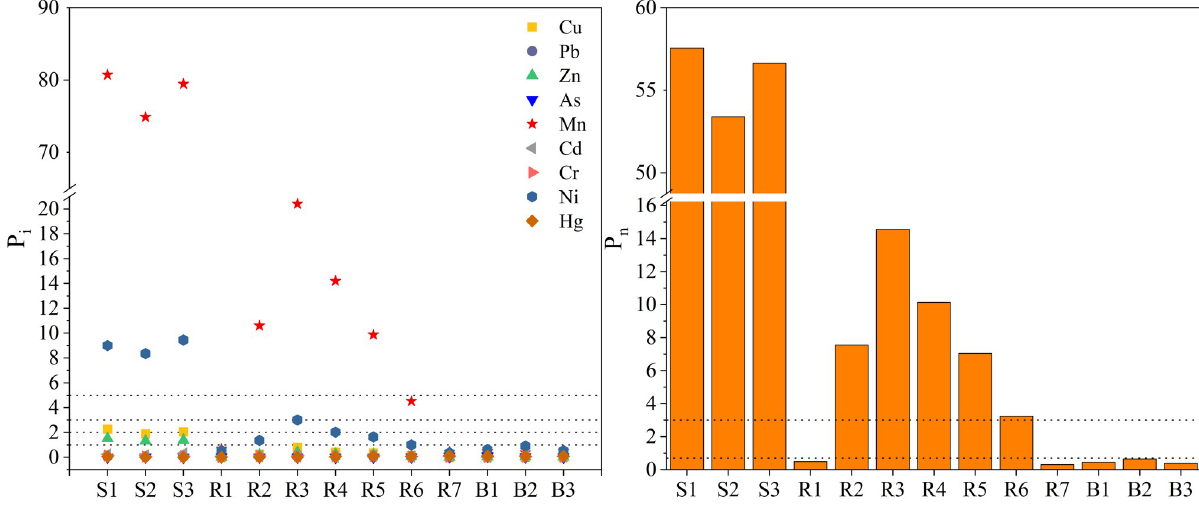
Fig 4. Pi and Pn of heavy metals in the Rongna